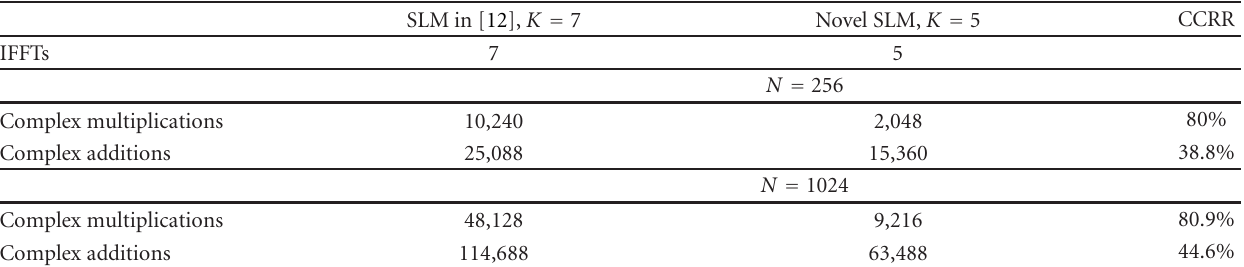
Table 7: Computational complexity of the SLM schemes in [12] and the novel SLM schemes when N = 256 and 1024. SLM in [12], K =